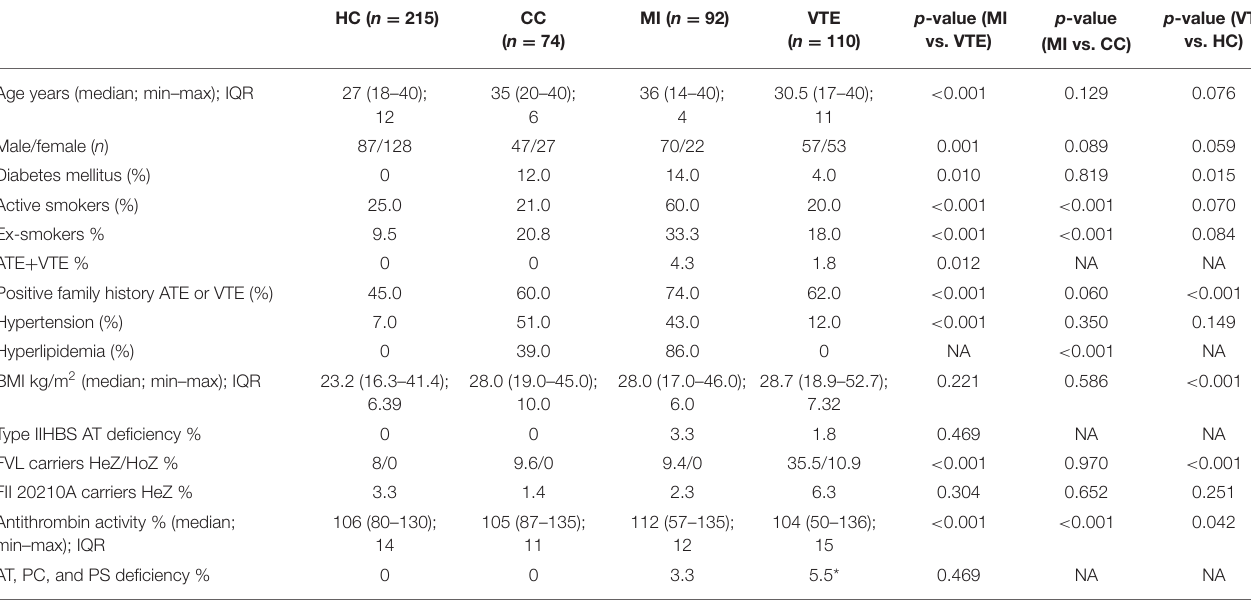
TABLE 5 | Clinical and laboratory characteristics of the young MI and venous thrombosis populations and their healthy controls.